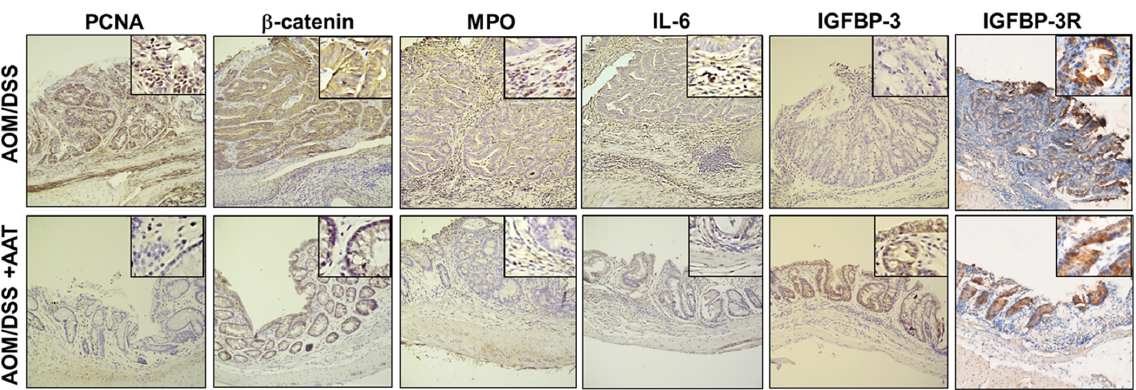
Figure 3. Effects of AAT on cytokine and antitumor factor production in CAC. Immunohistochemical staining for PCNA, β -catenin, MPO, IL-6, IGFBP-3 IGFBP-3R identified in colons from AOM/DSS-treated mice versus AOM/DSS and AAT-treated mice using an end-stage disease protocol as in Figure 2. Original magnification, ×20.